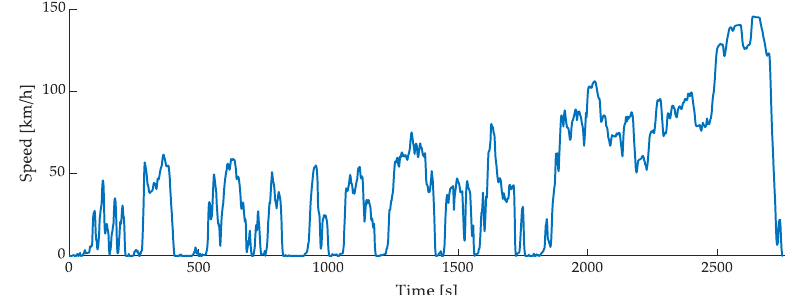
Figure A2. Speed profile over time of the Random Cycle generated using the TNO software.